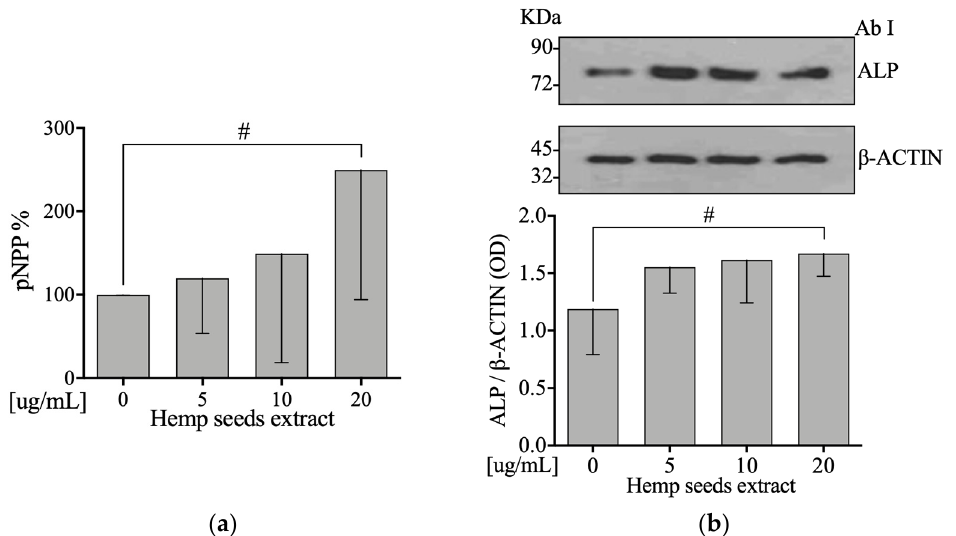
Figure 3. HSE increases activity and protein levels of Alkaline Phosphatase on Saos-2 cells. Semi- confluent cultures of human osteoblast-like cells (Saos-2) were incubated with HSE 5, 10, or 20 µg/mL for 24 hours. ( a ) ALP activity was measured by pNPP method. ( b ) Cell proteins were ana- lyzed by Western blotting with antibodies specific to alkaline phosphatase and β -actin. Data are represented as mean ± SD. Statistical analysis: Linear regression # p < 0.05.